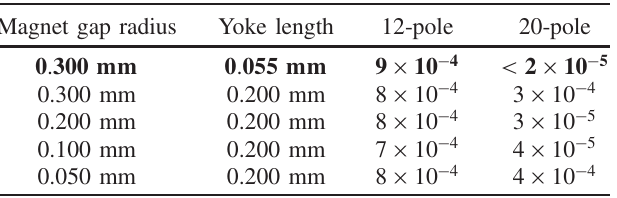
TABLE III. Multi-pole components from FEM simulation data normalized to the quadrupole field moment for MEMS quadru- poles. Multi-pole component data is evaluated at the edge of the 0.1% good field region for each simulated quadrupole. The prototype quadrupole is typeset bold. The 20-pole field compo- nent was below the resolution of the simulation for the prototype